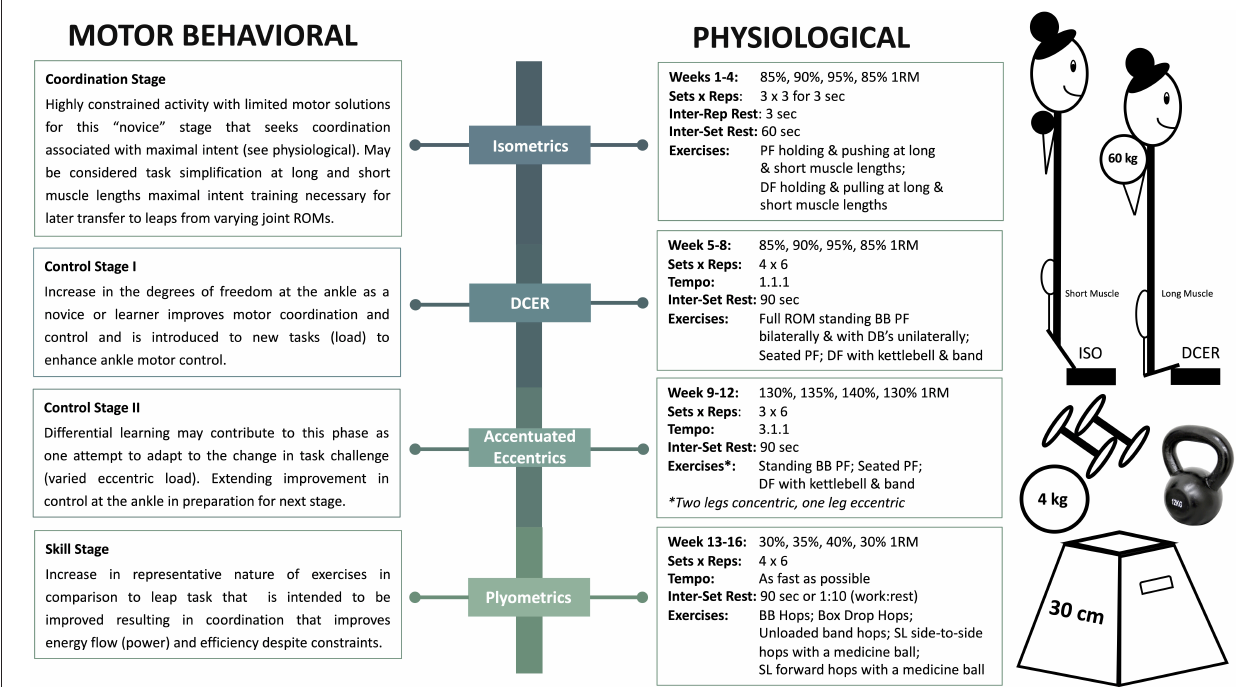
FIGURE 2 | Illustrates an example of a single-targeted block progression training with phase potentiation including intensity, volume, duration, and exercises. ISO, isometrics; DCER, dynamic constant external resistance; PF, plantarflexion; DF, dorsiflexion; ROM, range of motion; BB, barbell; DB, dumbbell; SL, single-leg. The stages of motor learning are described in Newell (1985). It should be noted that the linear nature of the proposed phases could be rearranged from a skill acquisition perspective or combined (differential learning). More research is required to determine if the ordered phases proposed from a physiological perspective are superior to any other ordering of phases. Further, despite dancers being in the “skill stage” in dance specific leaps, the use of the phases proposed with various changes to the task are in themselves differential learning approaches for even these skilled